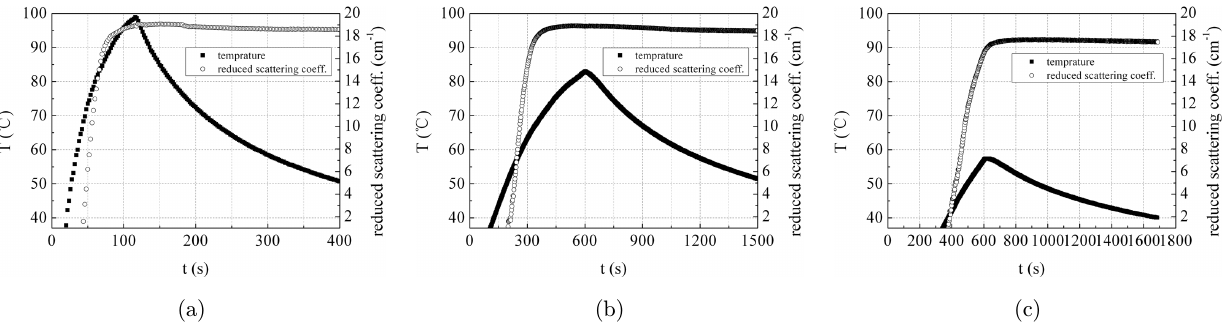
Fig. 5. The time dependences of temperature and (cid:1) 0 s during ablation. Microwave output for (a) 113 s, probe at 10 mm away from antenna; (b) 600 s, probe at 15 mm away from antenna; (c) 600 s, probe at 20 mm away from